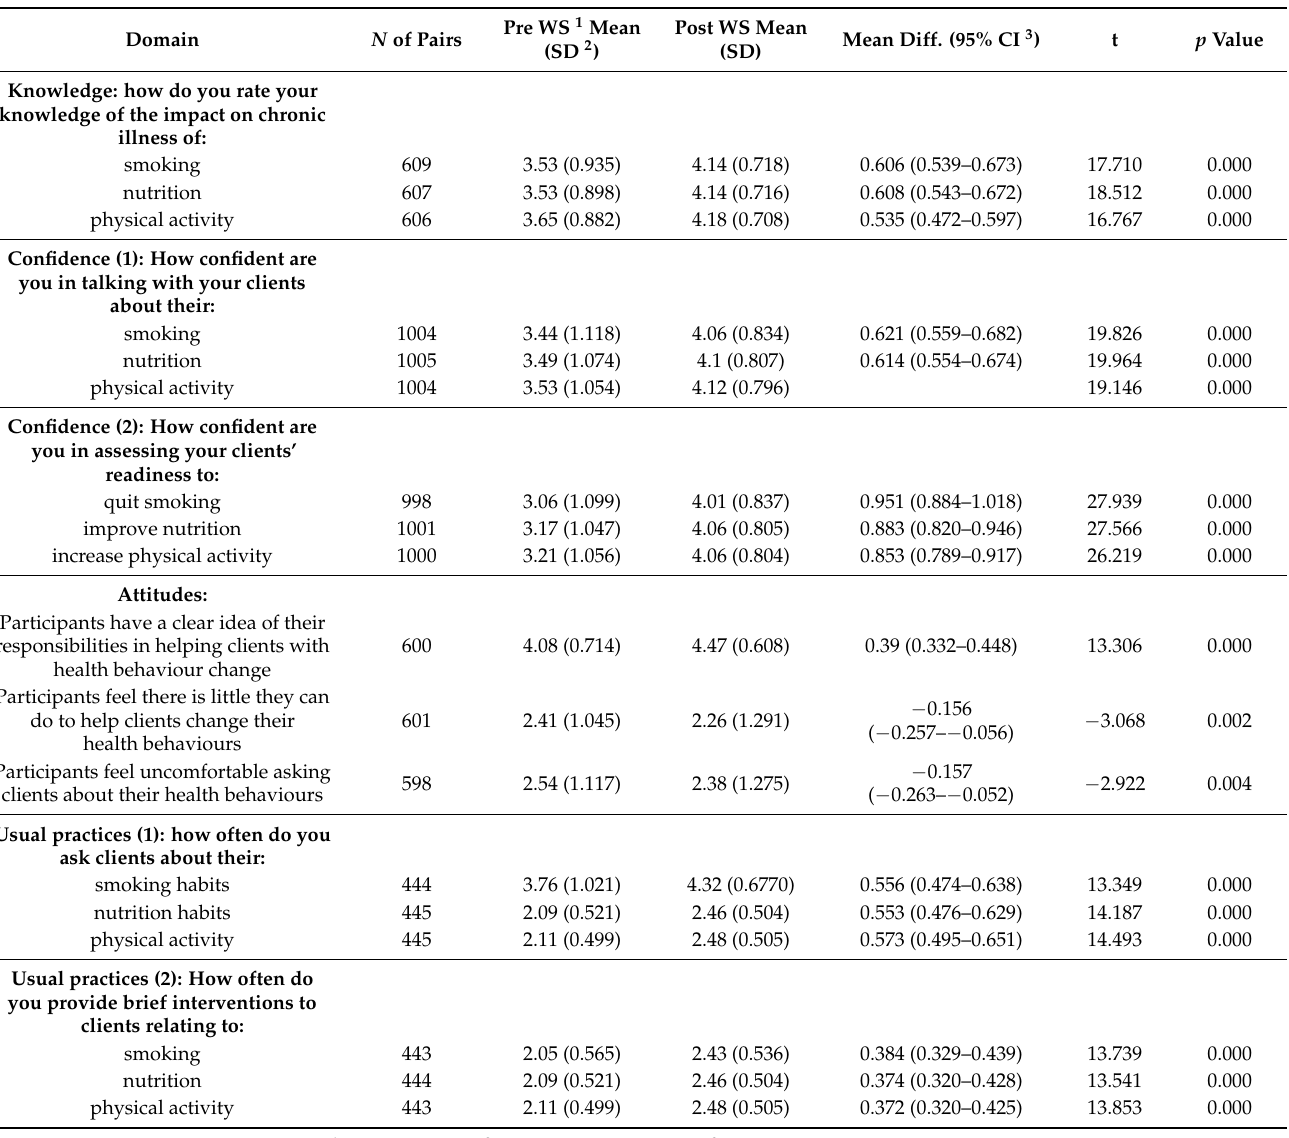
Table 2. Pre- and post-workshop